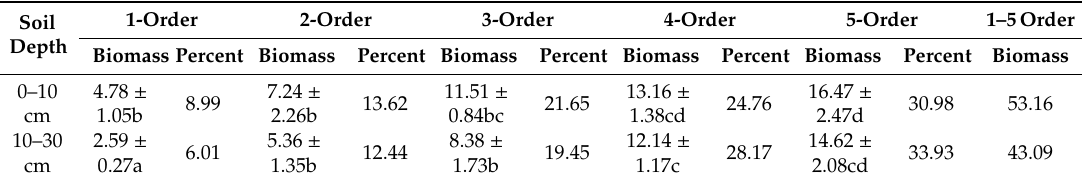
Table 3. Fine root biomass in each soil depth of noncrop trees.